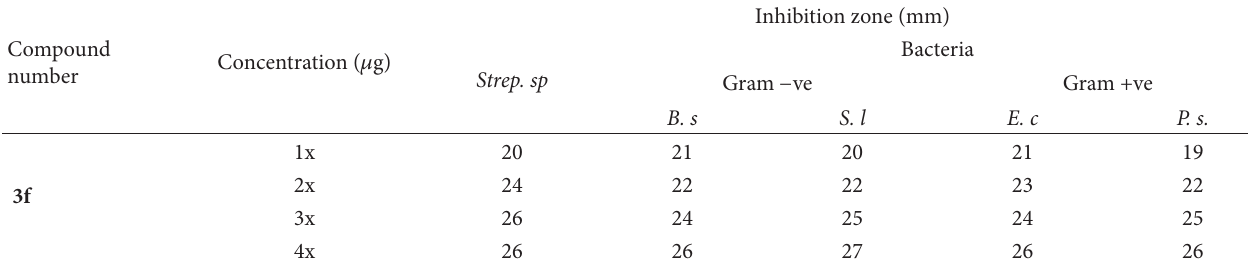
T 2: Effect of different concentrations of compound 3f showed moderate activity on bacterial